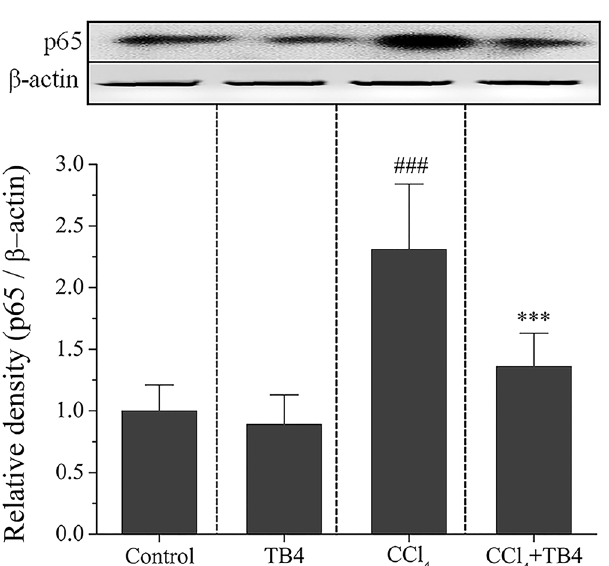
Figure 4. Immunohistochemistry of α -SMA, TGF- β 1, nitrative tyrosine, TNF- α and IL-1 β in liver sections from different groups with treatment as indicated in the figures. Original magnification of the microphotographs was showed in the figure. Four liver sections were randomly selected from each group and used for immunohistochemistry analysis. Here showed the representative results of immunohistochemistry.